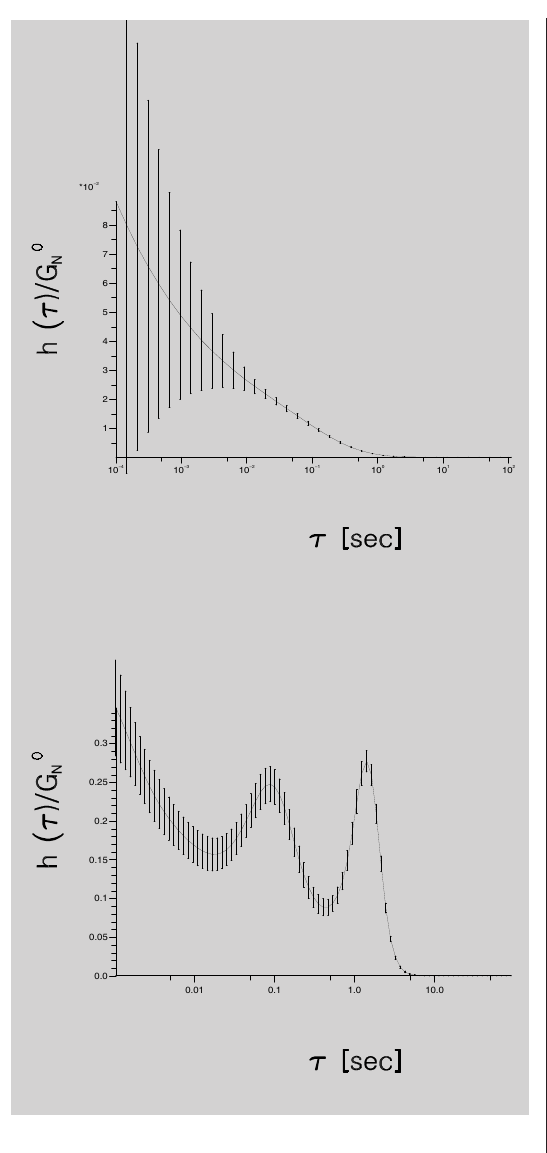
Figure 10: The terminal relaxation peak in the relaxation time spectrum is smoothed out for iPP. The spectrum for 70:30 is shown (upper pic- ture). There is a sharp terminal relaxation peak in the spectrum of Polystyrene 80:20 (lower